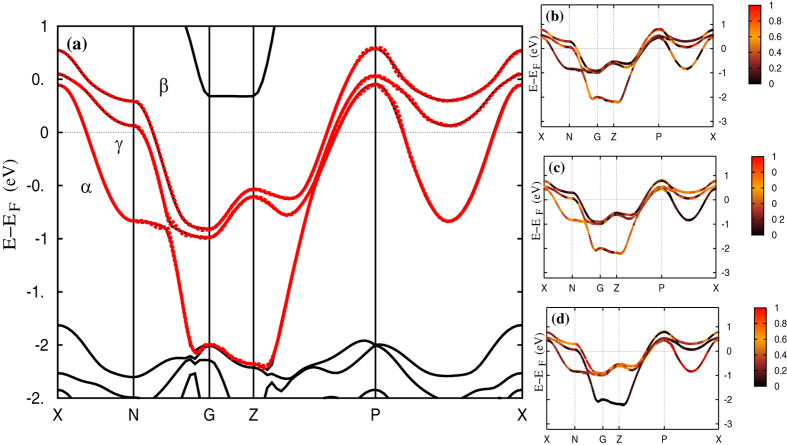
Left panel: Band structure (black solid lines) for Sr2RuO4 with SO coupling and Wannier fitting (red dotted lines) for the bands crossing the Fermi level.The bands with dominant dxz, dyz and dxy characters are shown as α, β and γ bands. Right panel: Band characterization of the Wannier fit bands for Sr2RuO4. The contribution of the dxy, dxz and dyz Wannier orbitals to the fitted bands are shown in (b–d) respectively through the color codes. Highest contribution is color red while black stands for the lowest. This intricate momentum-dependent interband mixing is a consequence of spin-orbital entanglement arising from sizable spin-orbit coupling (SOC) in Sr2RuO4.